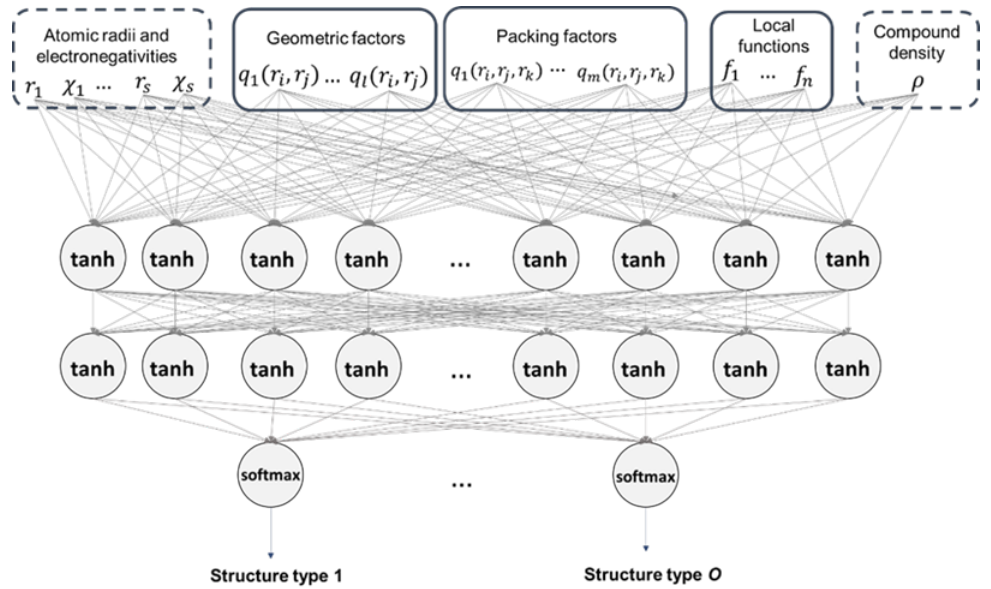
Figure 2. General architecture of the ANNs developed in this work. All ANNs had three layers. The activation function in the hidden layers was a hyperbolic tangent, whereas in the output layer the SoftMax function was used. The input data consisted of a series of features that could be grouped in the manner described above in the figure. The features enclosed in dashed lines were not used in the NEF ANNs, but they were in the WEF type.